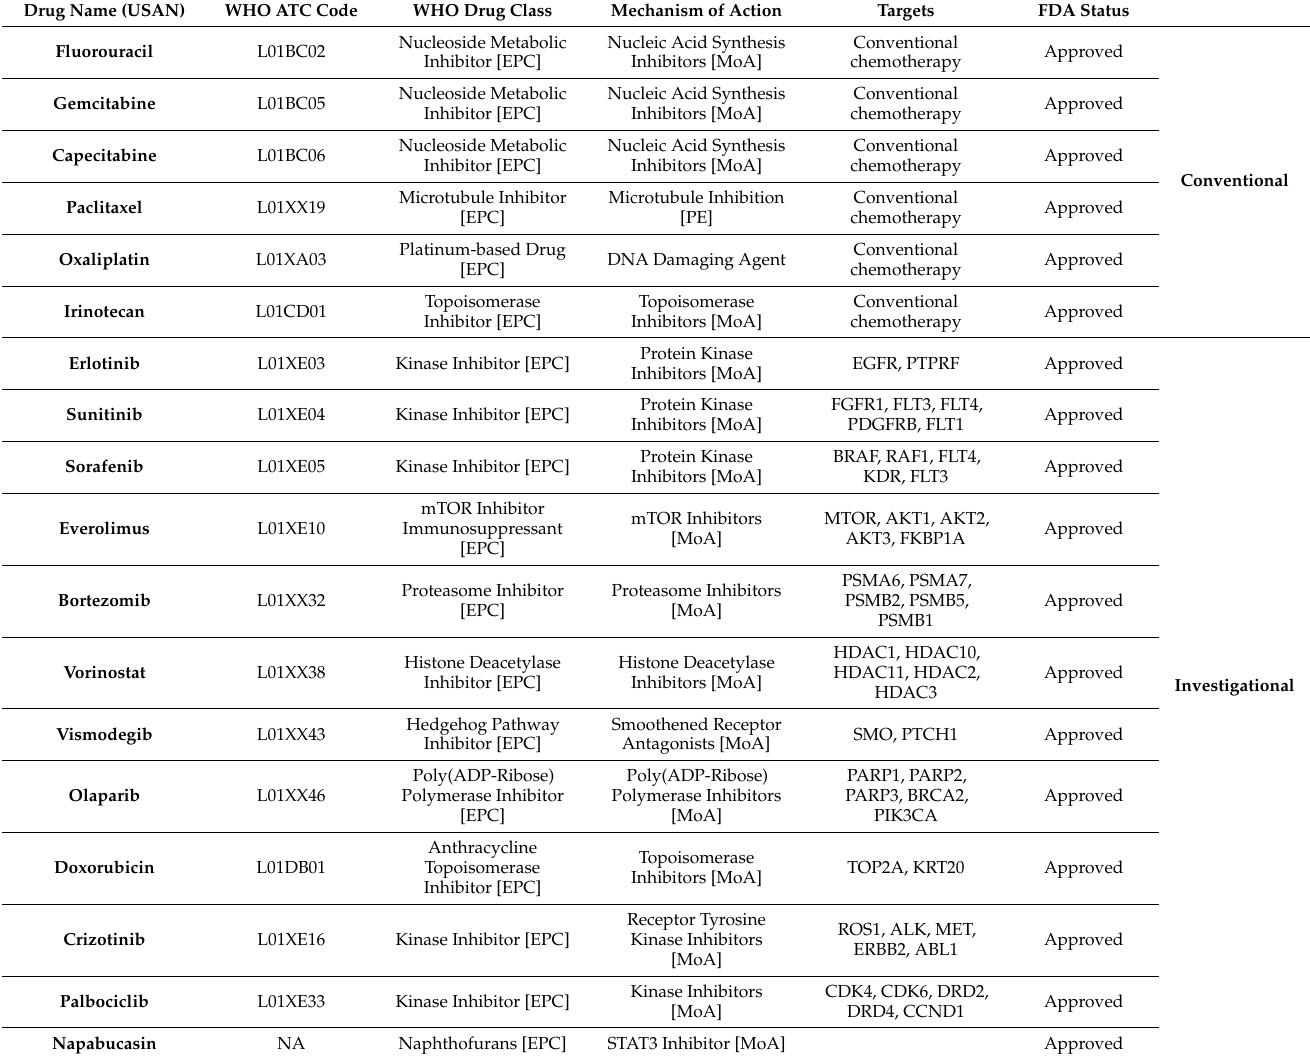
Table 1. Compounds included in multiplex PDO-based drug screening platform. Conventional therapies for the treatment of PDA, according to the National Comprehensive Cancer Network (NCCN), are highlighted in gray. Drug Name